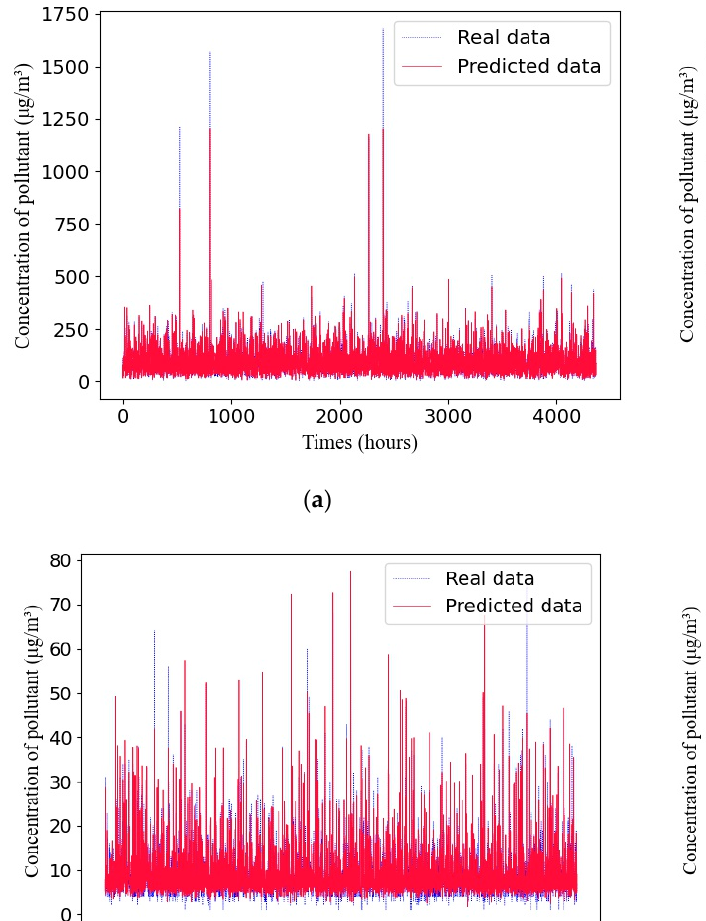
5. Conclusions In this paper, in order to better solve air-quality data with time-sequence information, we chose a GRU to address the task of air quality prediction. Inspired by the genetic algo- rithm, the adaptive GRU network structure was obtained via genetic processing, and op- timal prediction results of air quality were achieved. Compared with other, previously used air-quality-prediction methods, our proposed method showed a better performance in the air-quality-prediction task with three datasets. By applying the proposed method, the effective prediction of air quality can provide the government and relevant depart- ments with the changing trend of air quality in time, which is conducive to improving the ability of environmental-protection departments to study and judge the risk information of air pollution and providing early warnings. In addition, there are many factors influ- encing the air quality, including not only meteorological factors but also the social envi- ronment, human factors, and the geographical environment, etc., but due to the limited